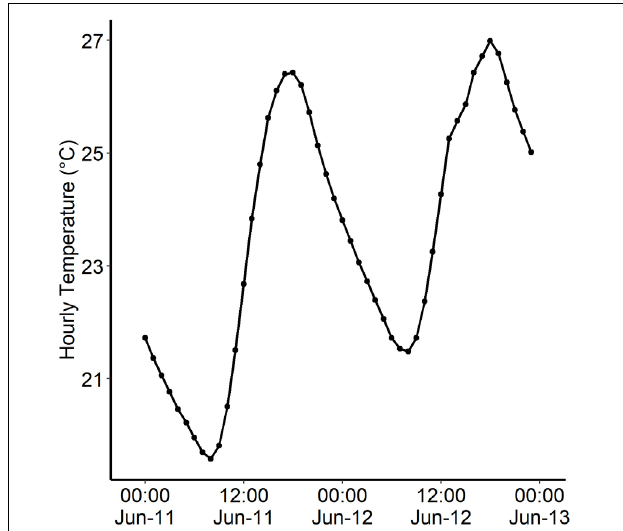
FIGURE 2 | An example of a temperature spike from the Credit River (43 ◦ 34 (cid:48) 40. (cid:48)(cid:48) N 79 ◦ 42 (cid:48) 06.3 (cid:48)(cid:48) W) during June 11th–13th 2017 (HOBO: Water temp pro v2). Credit River was the origin population for the Chinook offspring. Highest temperature (27.0 ◦ C) reached on June 12th, 2016 at 18:00